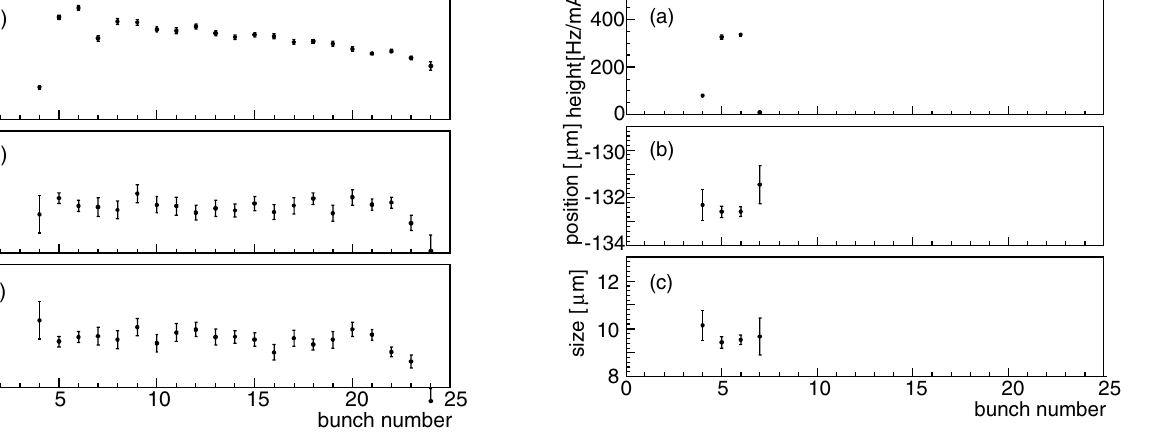
FIG. 8. Bunch dependence of the 3-bunch beam (vertical measurement). (a) The peak height; (b) the vertical peak ; (c) the peak width (cid:11) (cid:5) y (cid:6) meas position y p